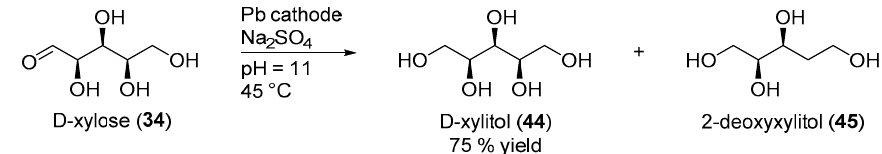
Scheme 22. Proposed mechanism for the direct electro-reduction of glucose.